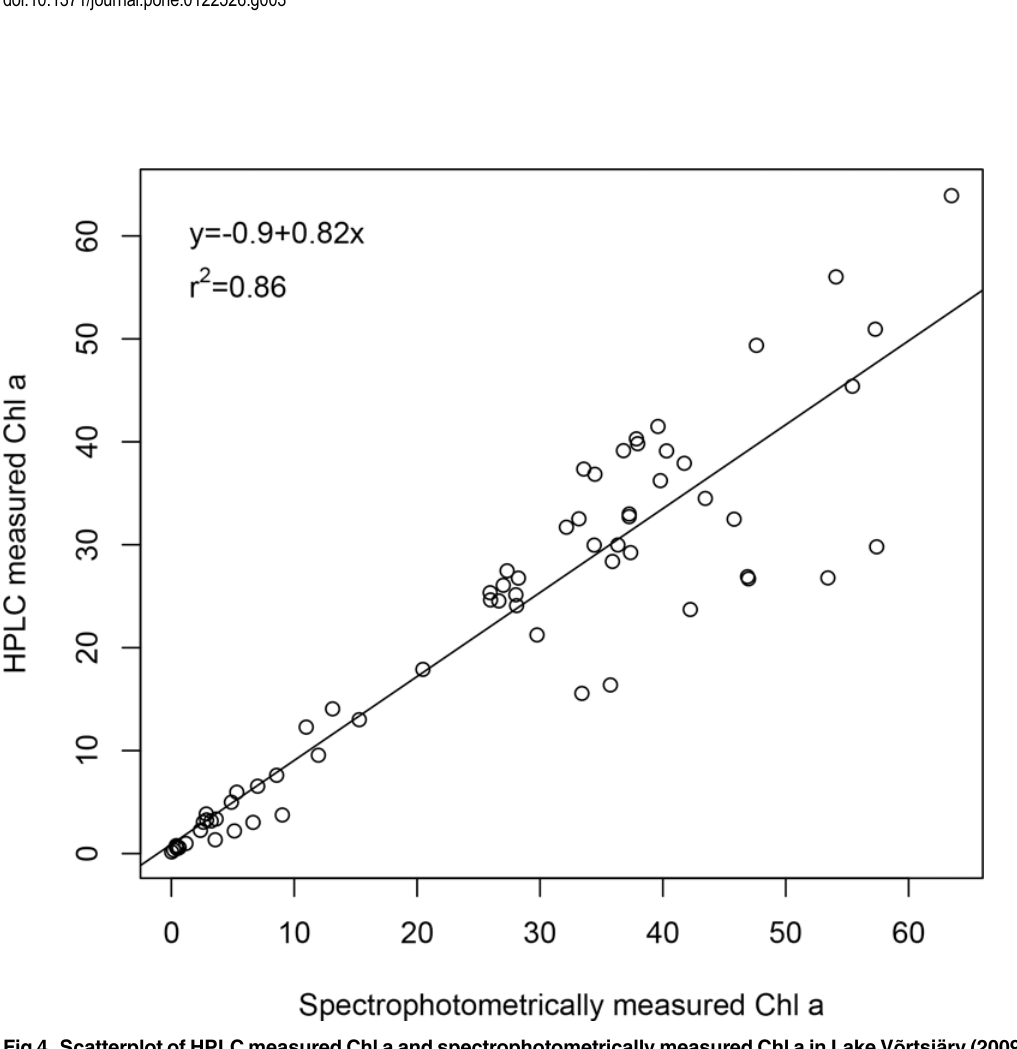
PLOS ONE | DOI:10.1371/journal.pone.0122526 March 24,